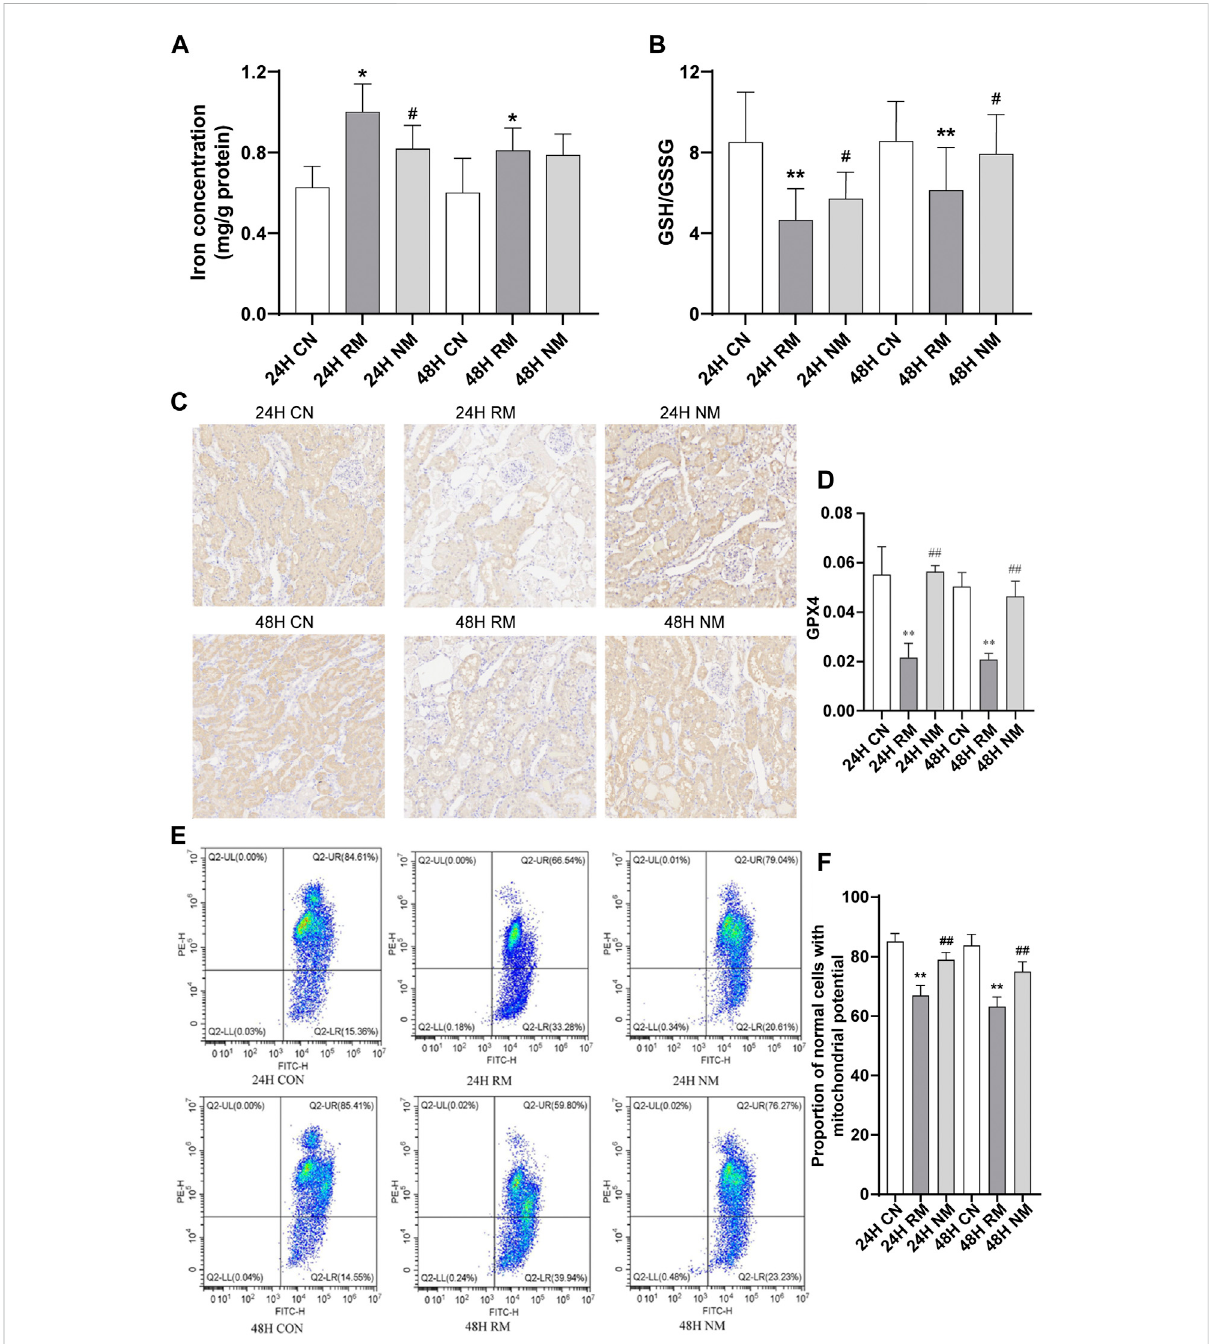
FIGURE 5 Effect of NM on renal tissue ferroptosis in RIAKI. (A) Iron level. (B) GSH/GSSG ratio. (C) Representative micrographs of immune staining of GPX4 in kidney tissues. Scale bar, 20 μ m. (D) Semiquantitative analysis showing GPX4 expression in kidney tissues. (E) Representative images of fl ow cytometric assessment of changes in the MMP in response to RIAKI. (F) Quanti fi cation of ratio of JC-1 aggregates versus JC-1 monomers (** p < 0.01vs. CN; * p < 0.05 and ## p < 0.01 vs.